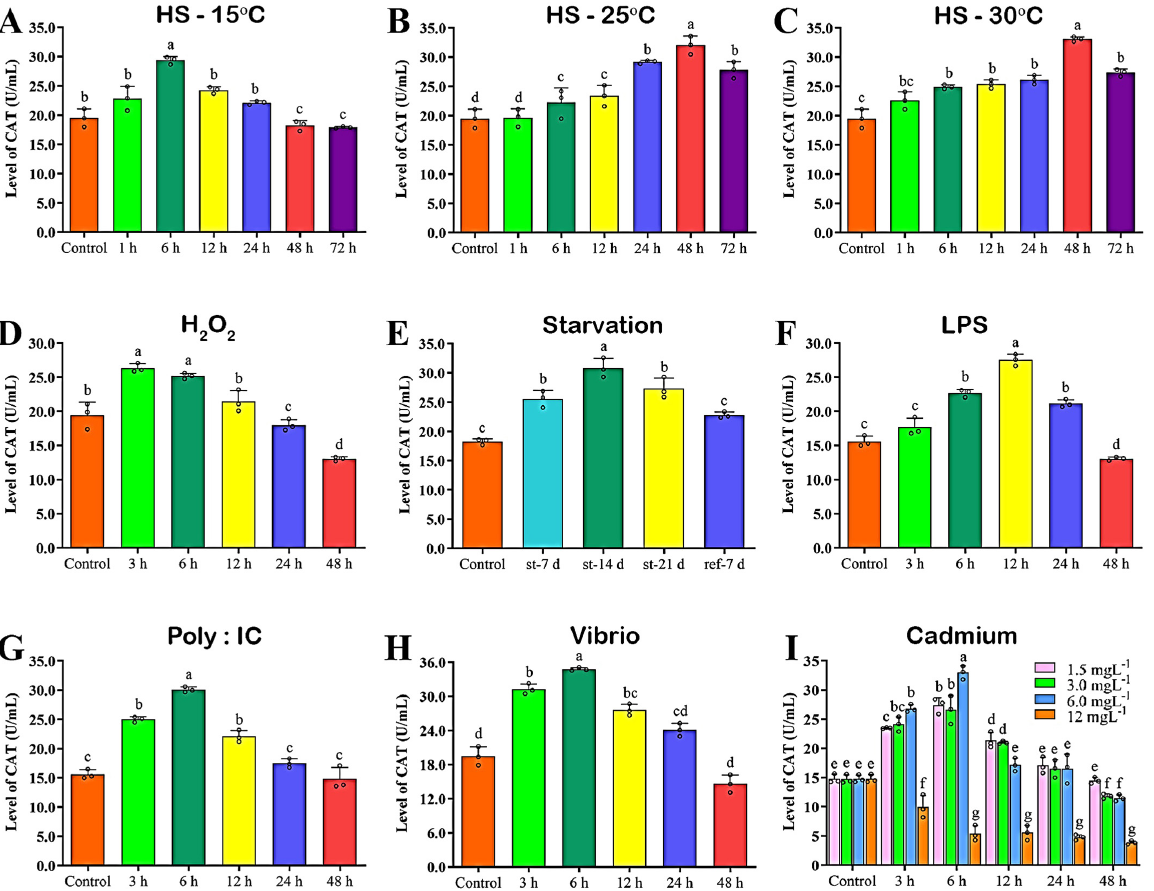
Figure 9. Catalase (CAT) activity in the different types of stress and immune-challenged plasma of Pacific abalone. ( A ) CAT activity in cold-stressed (15 °C) abalone, ( B ) CAT activity in heat-stressed (25 °C) abalone, ( C ) CAT activity in heat-stressed (30 °C) abalone, ( D ) CAT activity in H 2 O 2 -induced abalone, ( E ) CAT activity in starved abalone, ( F ) CAT activity in LPS-challenged abalone, ( G ) CAT activity in poly: (IC)-challenged abalone, ( H ) CAT activity in V. parahaemolyticus -challenged abalone, ( I ) CAT activity in cadmium-exposed abalone. Significantly different levels ( p < 0.05) are denoted by different letters.